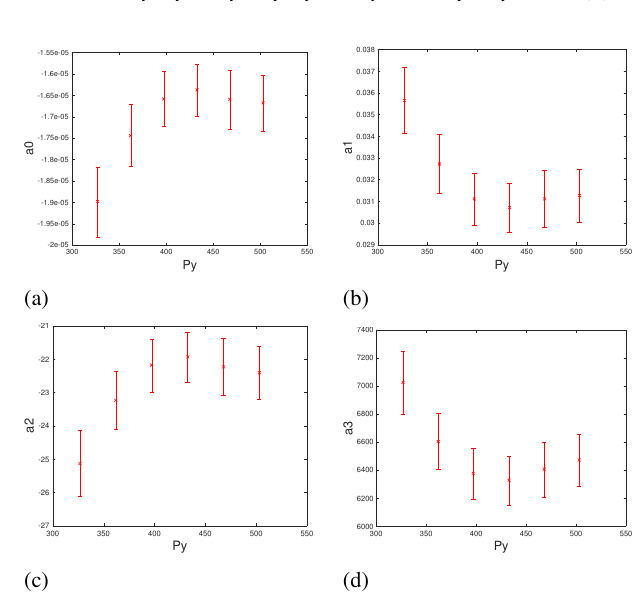
Figure 4 . Relationship between the coe ffi cients a i of the re- gression function S x against Y coordinate of the pupil